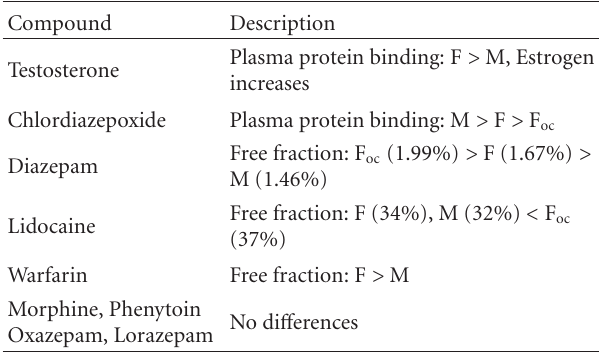
Table 2: Sex di ff erences in plasma